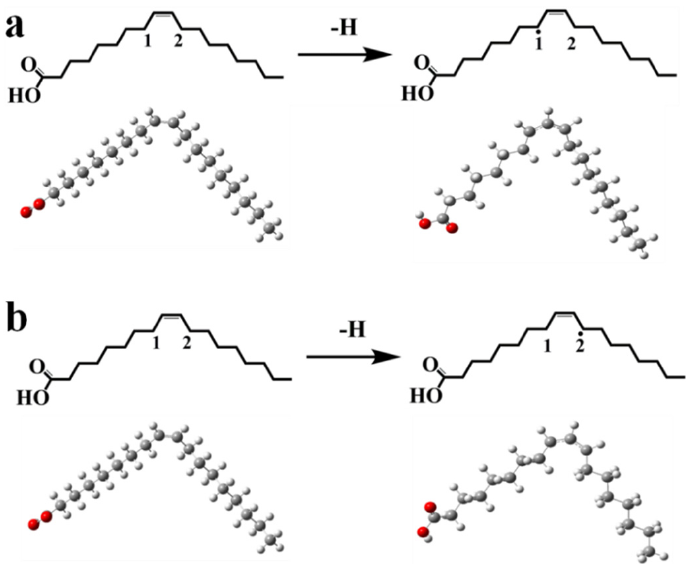
Figure 1. ( a ) Molecular structure of OA and OA radical on α -C (1#); ( b ) Molecular structure of OA and OA radical on α -C (2#).